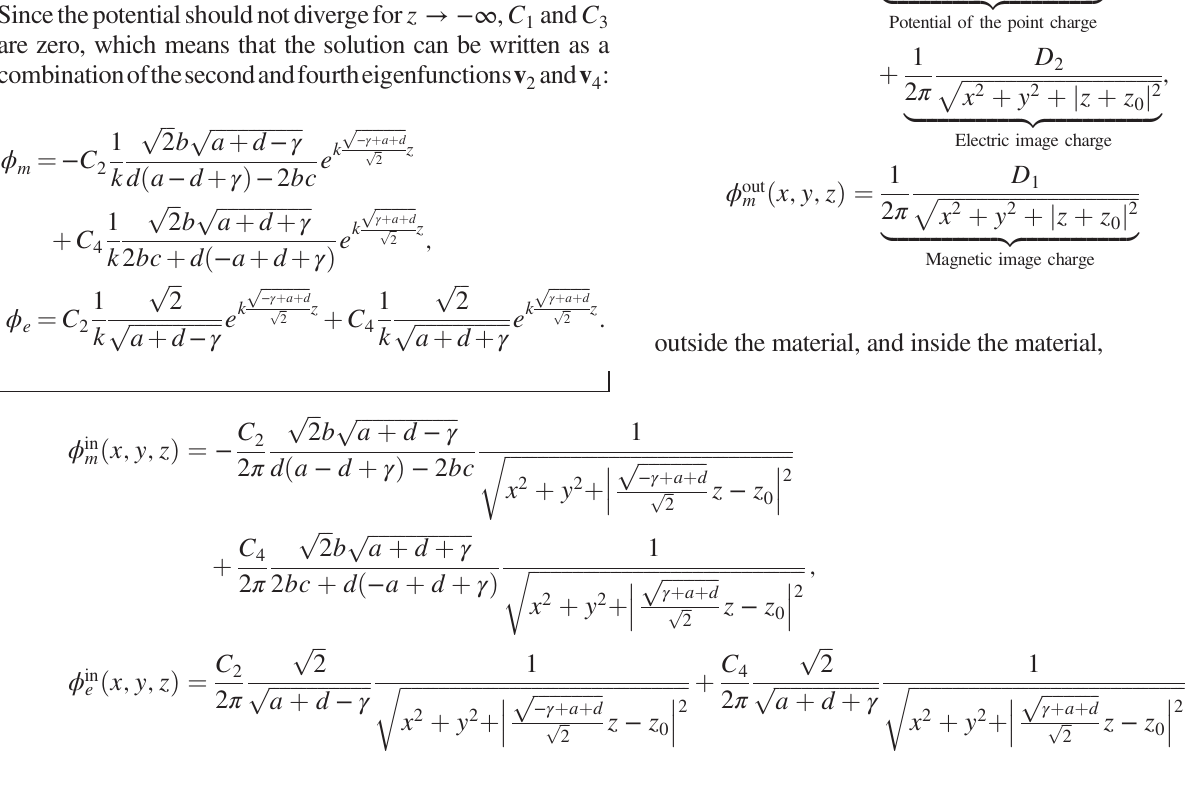
ffiffiffiffiffiffiffiffiffiffiffi ffiffi p p 2 b a þ d þ γ ffiffi p ffiffiffiffiffiffiffiffiffiffiffi 2